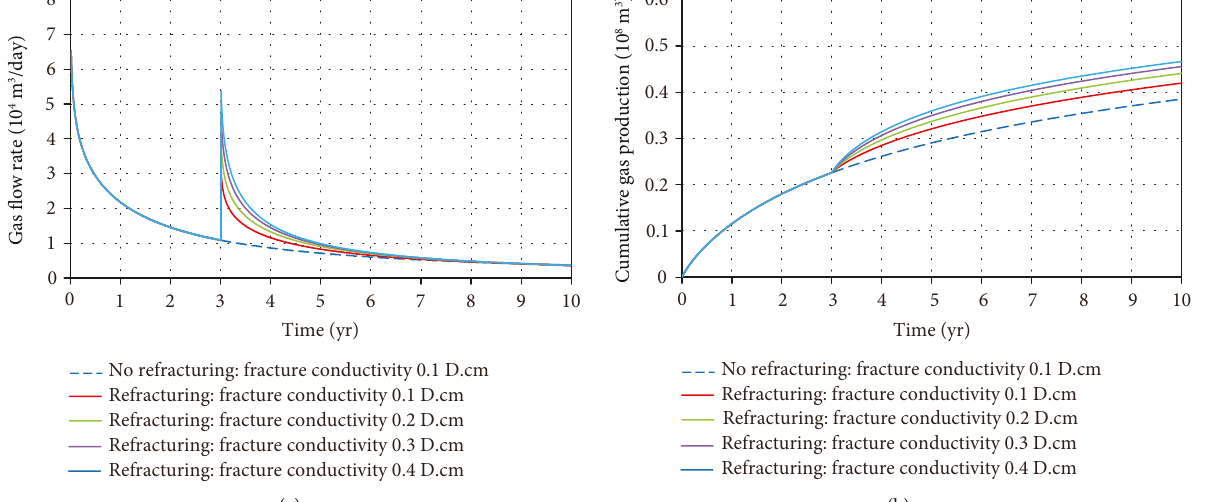
Figure 7: Well performance of refracturing through existing perforation clusters: (a) gas fl ow rate and (b) cumulative gas production.